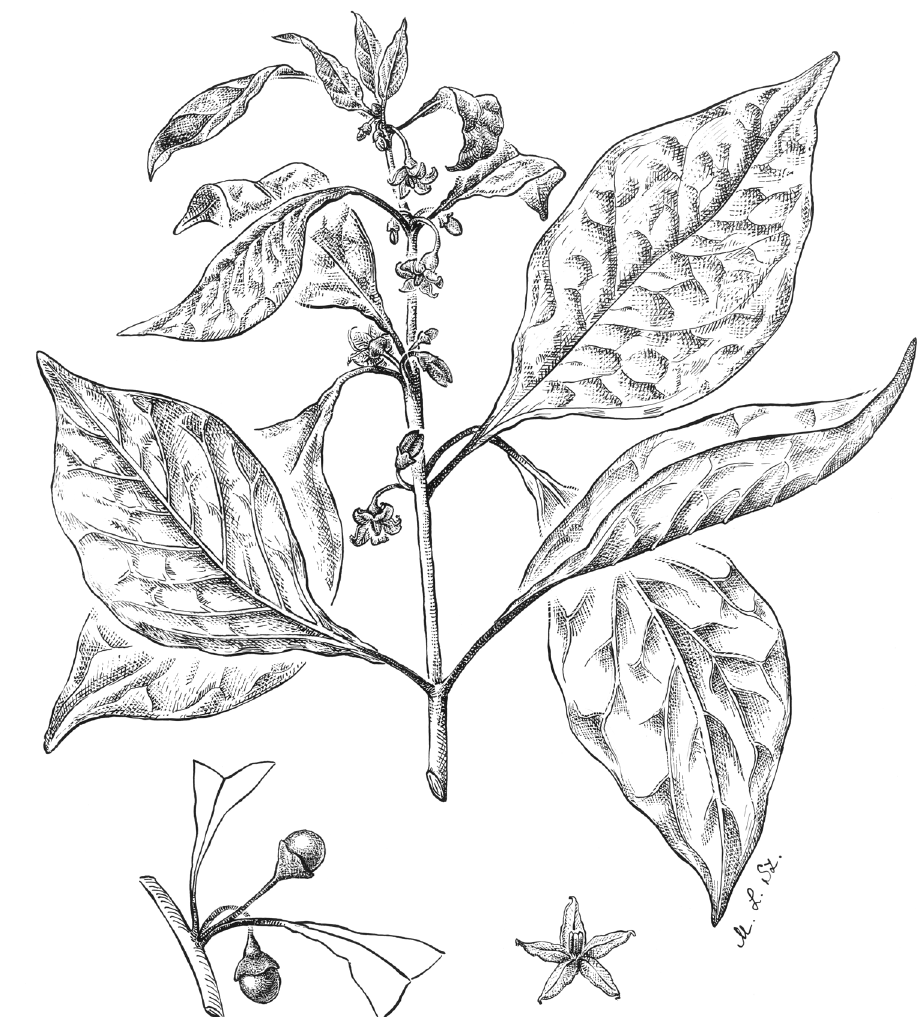
Figure 48. Lycianthes shanesii (F.Muell.) A.R.Bean. Drawing) by M.L. Szent-Ivany, first published in Symon and Clarkson (1985, as S. shanesii F.Muell.). Courtesy of the Board of the Botanic Gardens and State Herbarium (Adelaide, South Australia), reproduced with